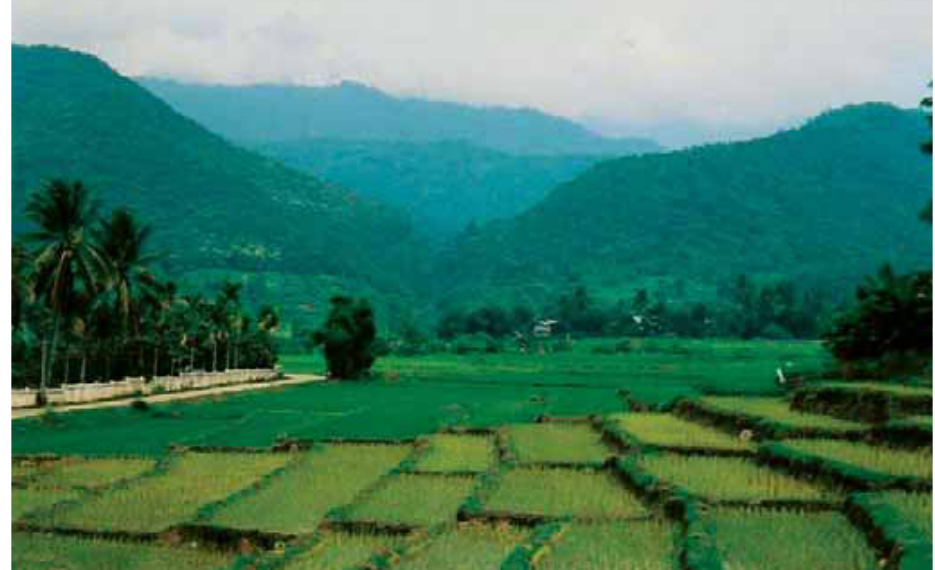
Fig. 11. Wine-glass canyon developed where the Nam Khun crosses the Pua Fault. Compare canyon profile with fig. 8.